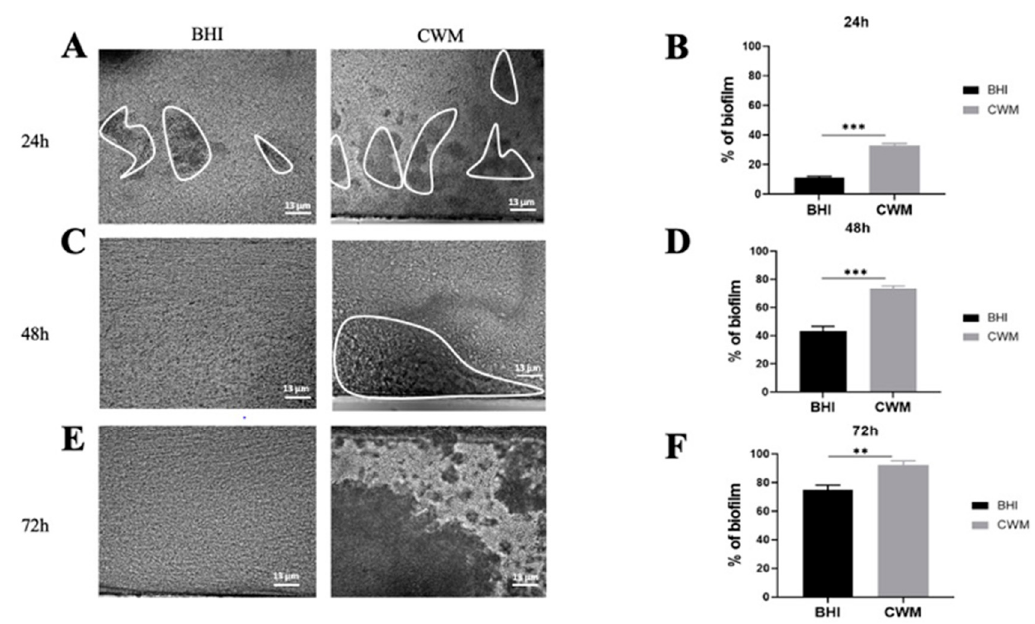
Figure 5. Kinetics of biofilm formation of coculture of Staphylococcus aureus Newman and Pseudomonas aeruginosa PAO1 in the BioFlux TM system. The ratio of coculture used was 1:1. The two species were added into the system simultaneously. ( A , C , E ) correspond to representative images taken at different times (( A ) 24 h; ( C ) 48 h and ( E ) 72 h) of biofilm formation in the CWM and BHI media. The images are the result of one of the three experimental triplicates. Biofilm is visualized by the black part in between the white lines. Percentages of biofilm formation are presented at 24 h ( B ), 48 h ( D ) and 72 h ( F ) postincubation in both media after three independent experiments They were determined by the ImageJ software application. Results are presented as the mean ± standard deviation. Statistics were performed using a t -test on GraphPad Prism version 7. Ns, p > 0.05; ** p < 0.01; *** p < 0.001.